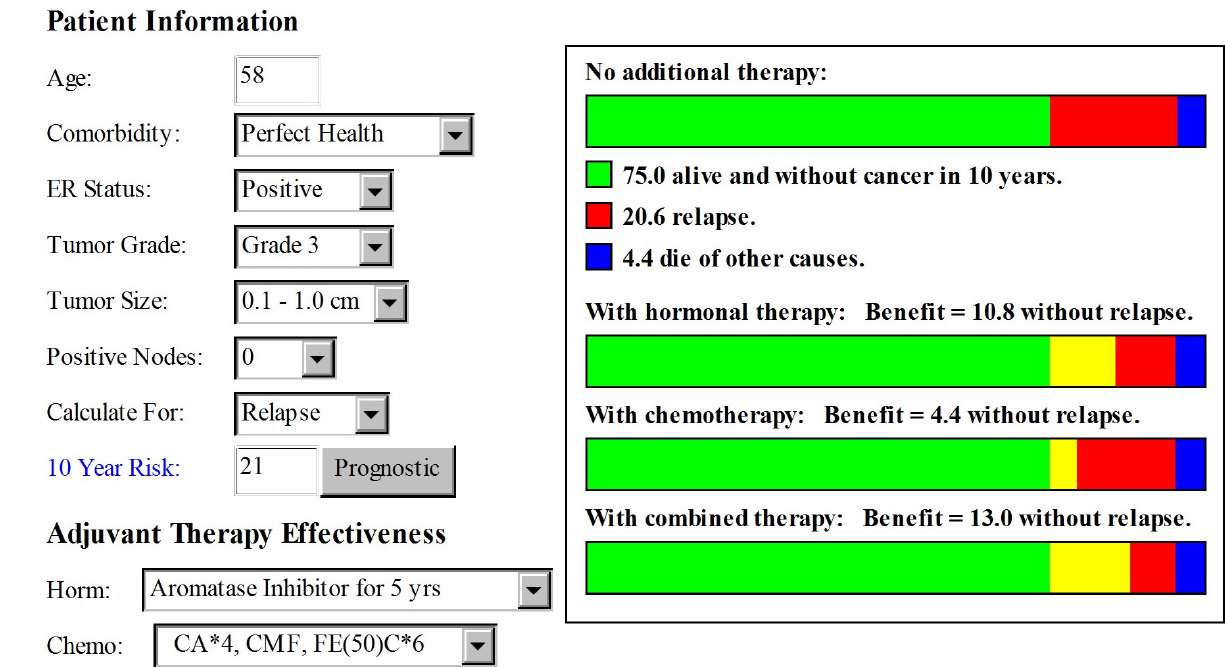
Figure 1. Prognostic data based on population-based analysis with Adjuvant! Online version 8.0 [4].